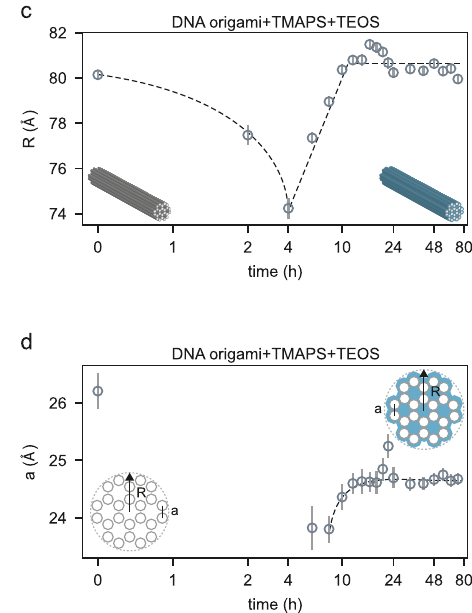
Fig. 2 | Effect ofTMAPS and TEOS on origami radius and interhelical distance. Radiioftheoverallcylinder-shaped24HBsandinterhelicaldistanceextractedfrom Supplementary Fig. 6 and from Fig. 1a plotted as a function of TMAPS incubation time ( a , b ) and of TMAPS and TEOS incubation time ( c , d ). Dashed lines serve as